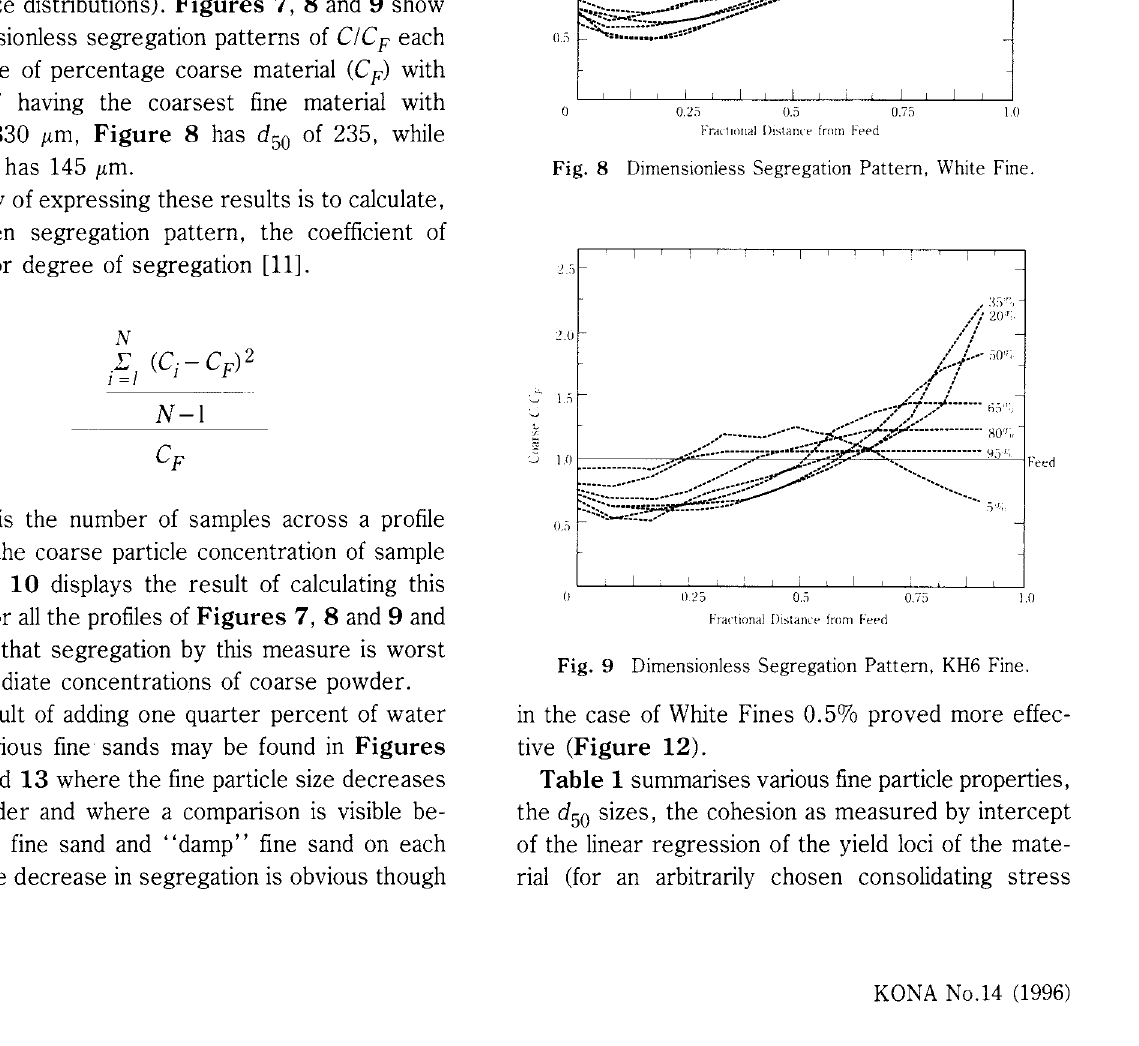
Fig. 8 Dimensionless Segregation Pattern, White Fine.